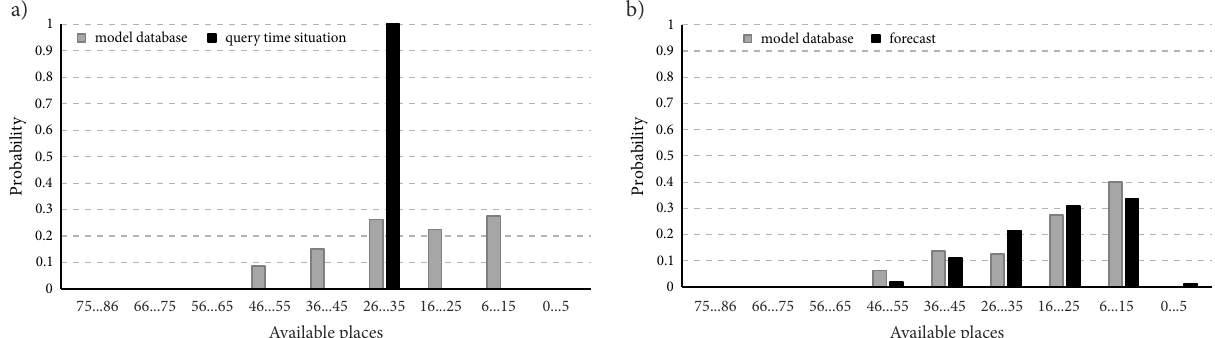
Figure 5. Graphical presentation of the received results for standard situation: a – situation at query time; b – forecast for arrival time